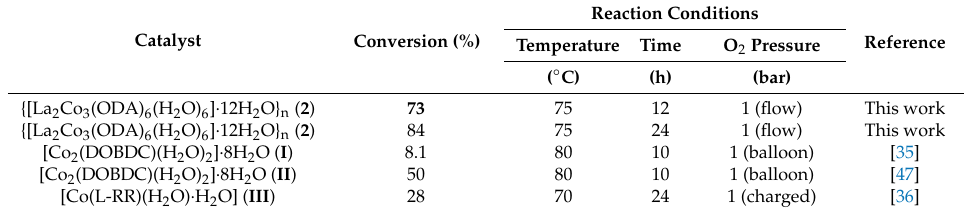
Table 5. Catalytic results of di ff erent Co II -based metal organic frameworks (MOFs) using solvent free conditions.